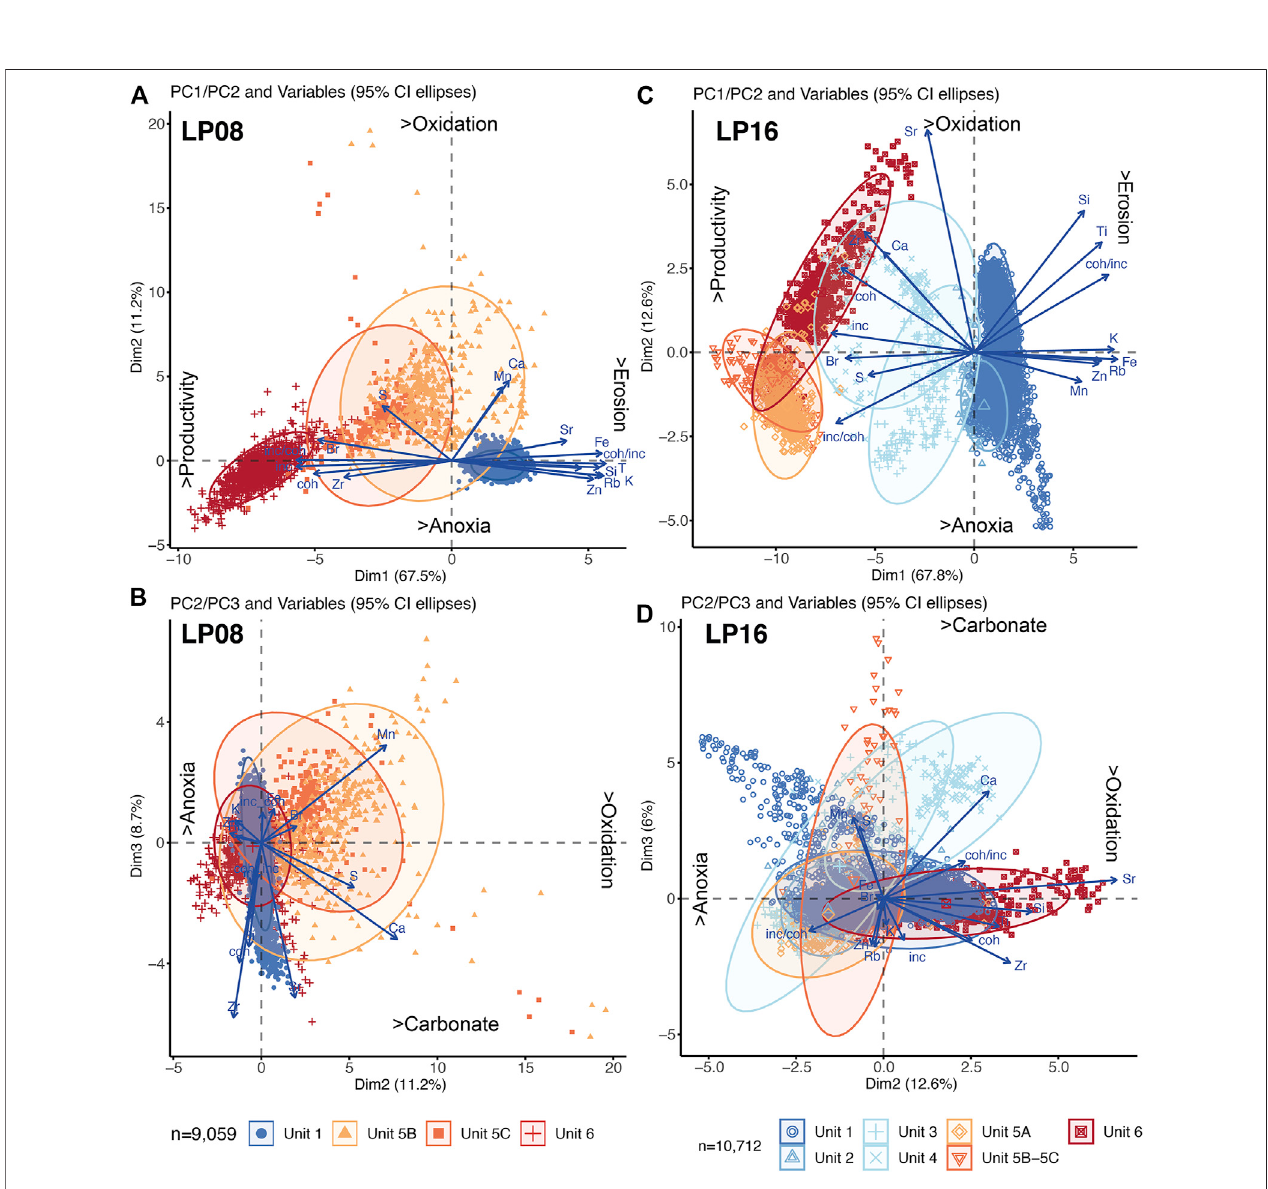
FIGURE 7 | Principal component analysis (PCA) biplots and summary interpretation for (A) LP08: PC1/PC2, (B) LP08: PC1/PC3, (C) LP16: PC1/PC2, and (D) LP16: PC1/PC3. Further analysis and PCA biplots are shown in Supplementary Figures S2, S3 ). ‘ As-measured ’ 200 μ m → 2 mm element/total scatter XRF-CS datasets (expressed as a percentage of total scatter normalised sum) were used. Data were log n transformed, centred, standardised, and then grouped by lithofacies units as de fi ned by CONISS cluster analysis shown in Figure 5 . Data were plotted and analysed in R, with the fi nal layout achieved in Adobe Illustrator.